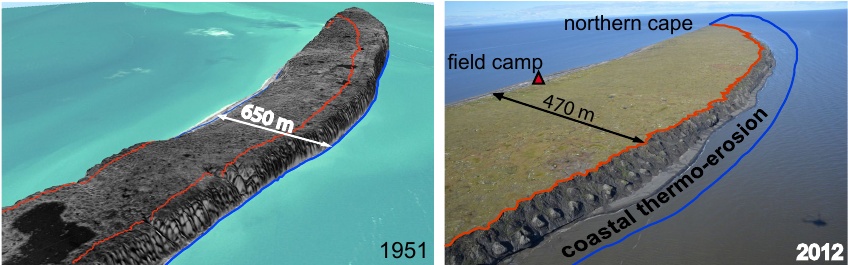
Figure 2. Coastal thermo-erosion over time in the northern part of Muostakh Island. Historical cliff bottom (1951, blue) and current cliff top line (2012, red) border the subaerial coastal thermo-erosion zone. Left: orthophoto of historical aerial imagery draped over 1951 DEM. Note: the lake in the lower left has been drained during the observation period. Right: oblique photograph taken from helicopter in August 2012. Location of 2011 and 2012 field camp, maximum island width for scale.